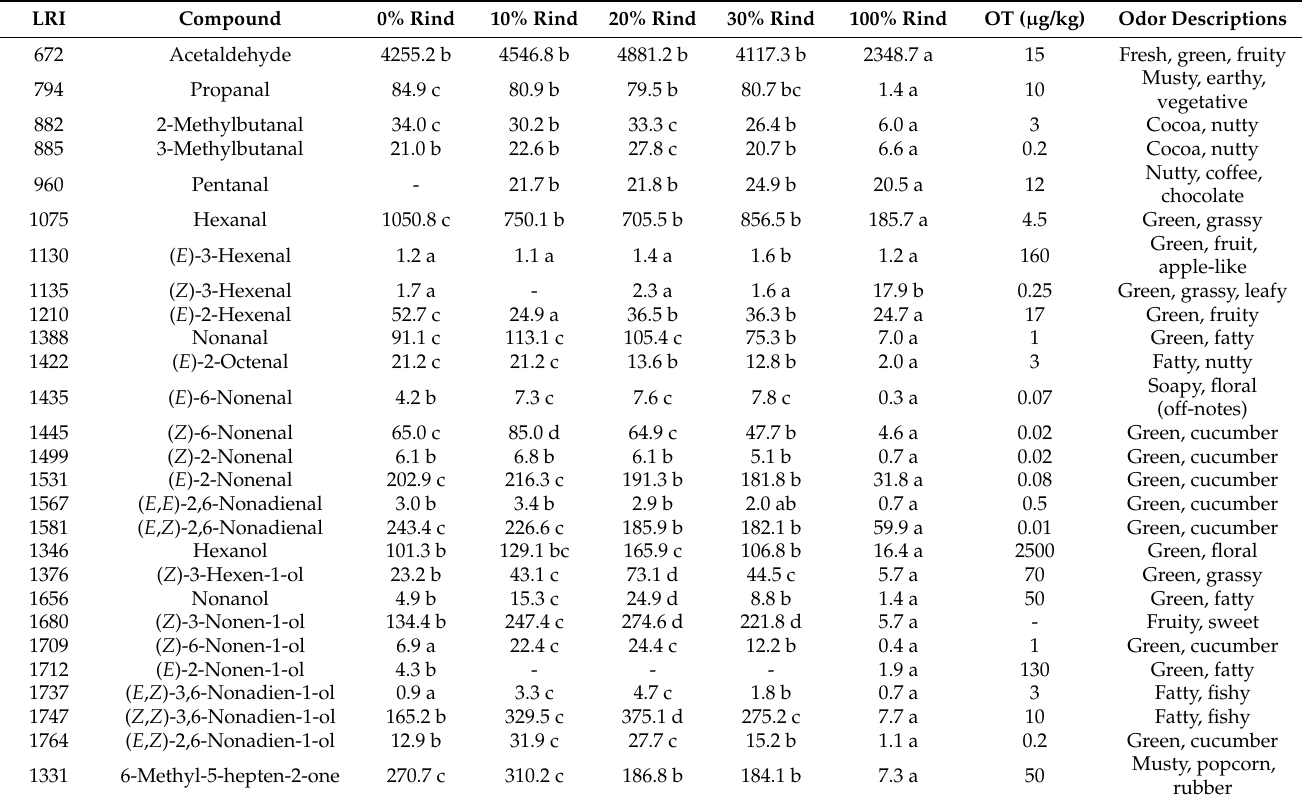
Table 2. Volatile compounds in watermelon rind-flesh blends ( µ